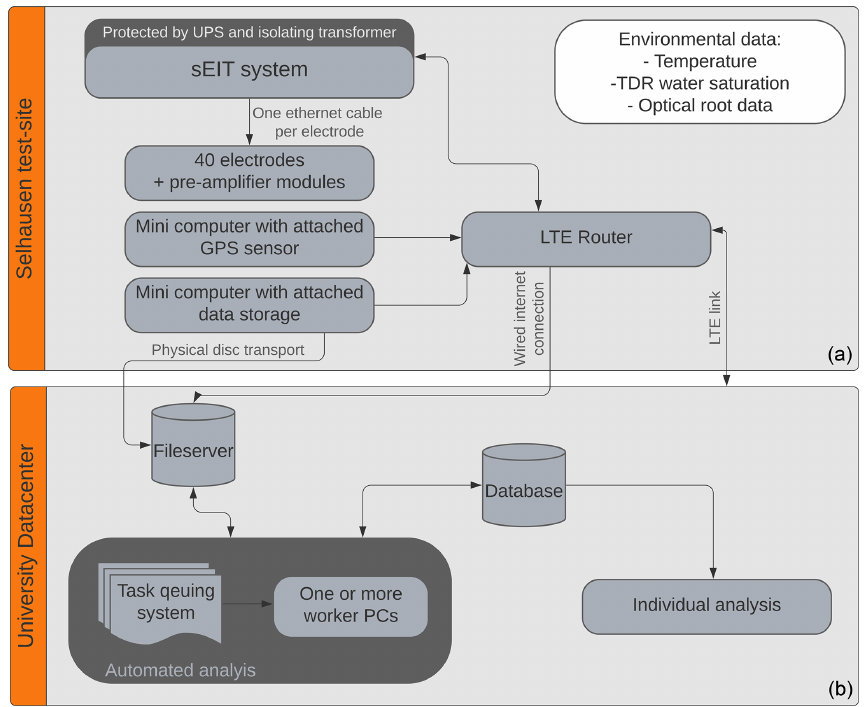
Figure 2. Schematic overview of sEIT monitoring system. The system is divided into two major parts: an on-site (a) and a remote (b)